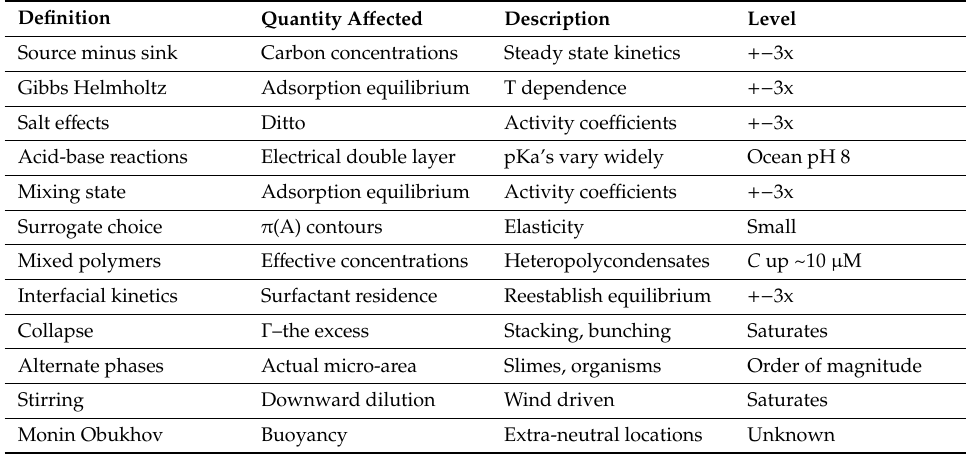
Table 5. Some uncertainties in the global expression of our text equations, with rough estimates of their severity. Processes are discussed in order of occurrence along the sequence—macromolecular release into the upper water column through to final modulation of interface energetics. The reader may wish to think of error bars as potentially cumulative or